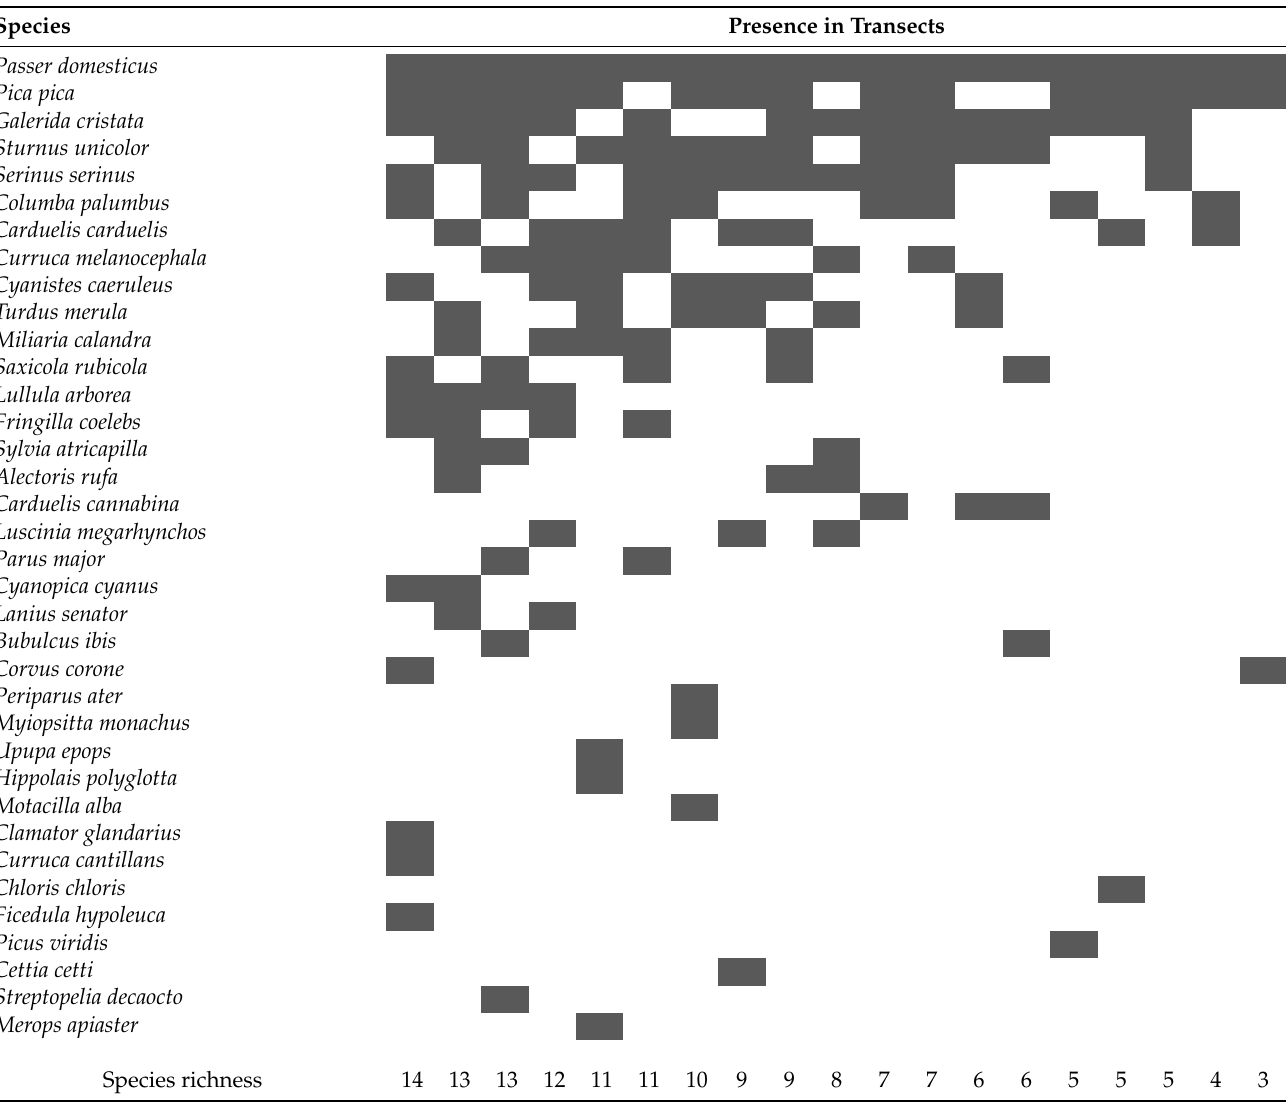
Table 2. Nested structure of bird communities sampled in drove roads. Bird species (rows) and transects (columns) are organized to show species presences (gray squares) optimally packed close to the upper-left corner. Species richness of each transect is shown under the ‘nestedness diagram’.